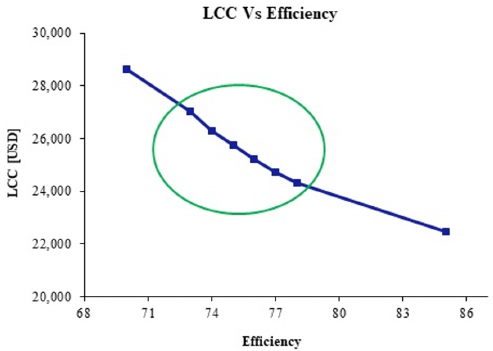
Figure 21. LCC against CP